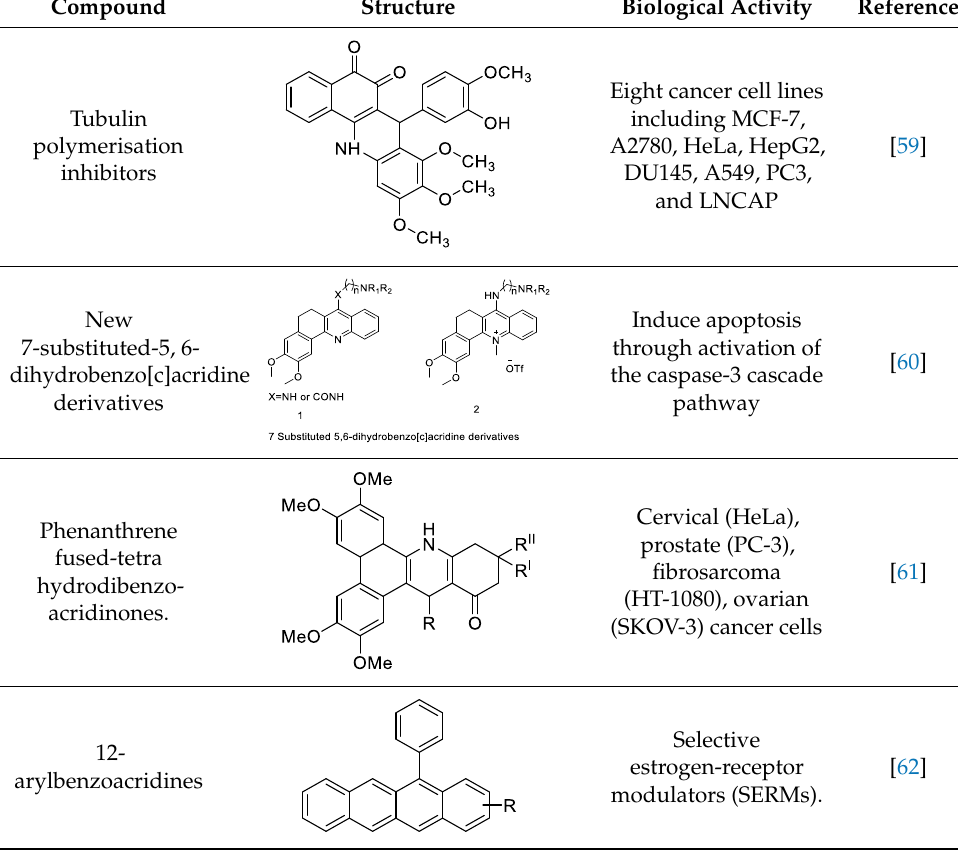
Table 8. Benzoacridine as an anti-tumour